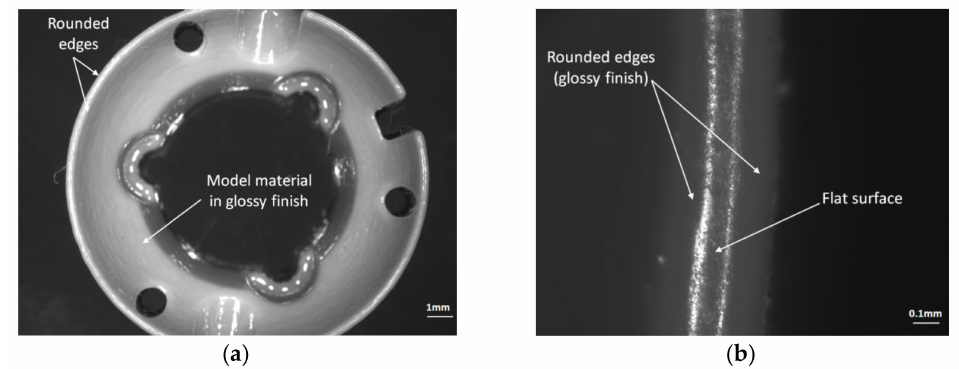
Figure 18. The upper surface of the circular artifact manufactured by the Objet EDEN 350 PolyJet. ( a ) Upper surface in glossy mode; ( b ) upper edge detail in a glossy